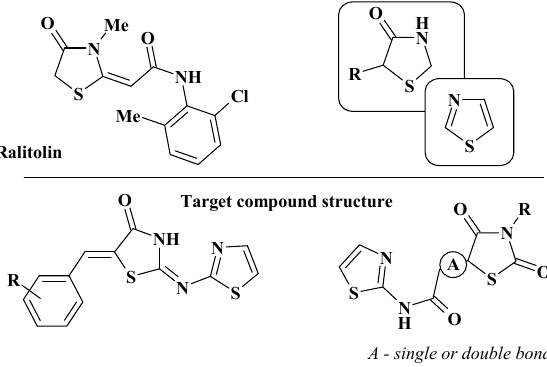
Figure 2. Structure of target compounds.